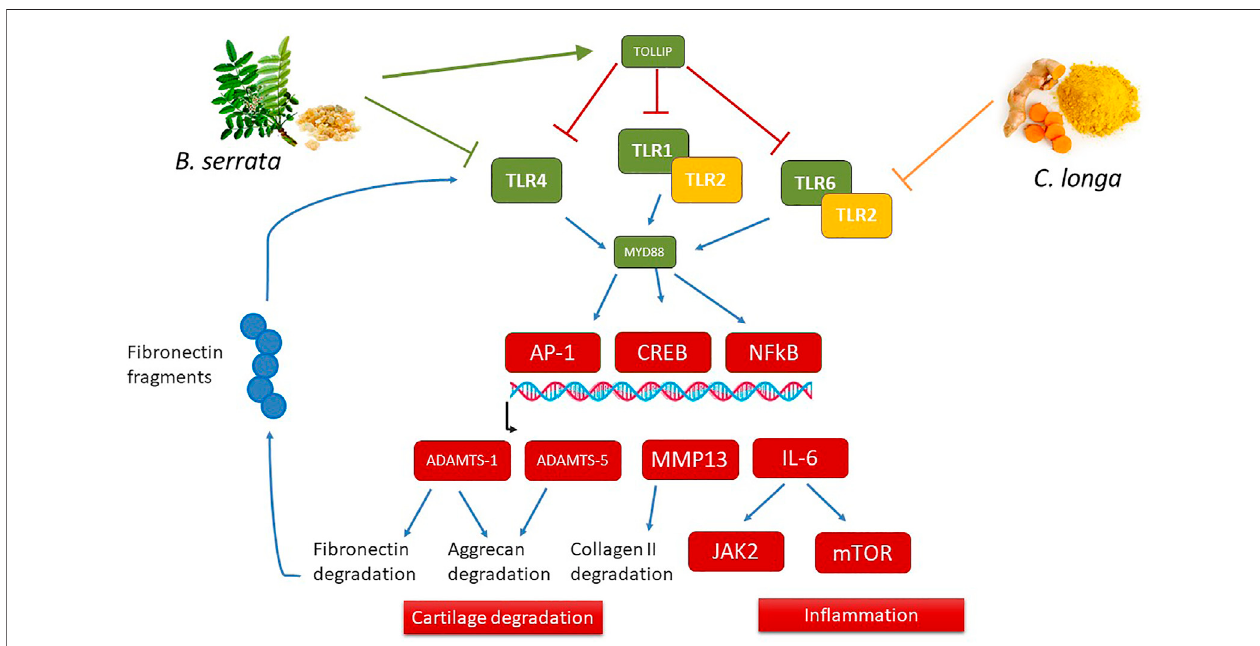
FIGURE 7 | Schematic overview of distinct action of C. longa and B. serrata on TLRs pathways. B. serrata decrease TLR1-4-6 and MyD88 gene expression after 24 handTLR2proteinafter72 h,andalsoup-regulatedTOLLIPgeneexpression,aninhibitorofTLRs,while C.longa onlydecreasesTLR2expressionandprotein.Both C. longa and B. serrata decreased downstream genes of the TLRs pathways like ADAMTS1, ADAMTS5, MMP-13, IL-6, and JAK2. As ADAMTS1 can degrade fi bronectin, and fi bronectin fragments could induce TLR4 activation, C. longa and B. serrata could attenuate this in fl ammation ampli fi cation loop.